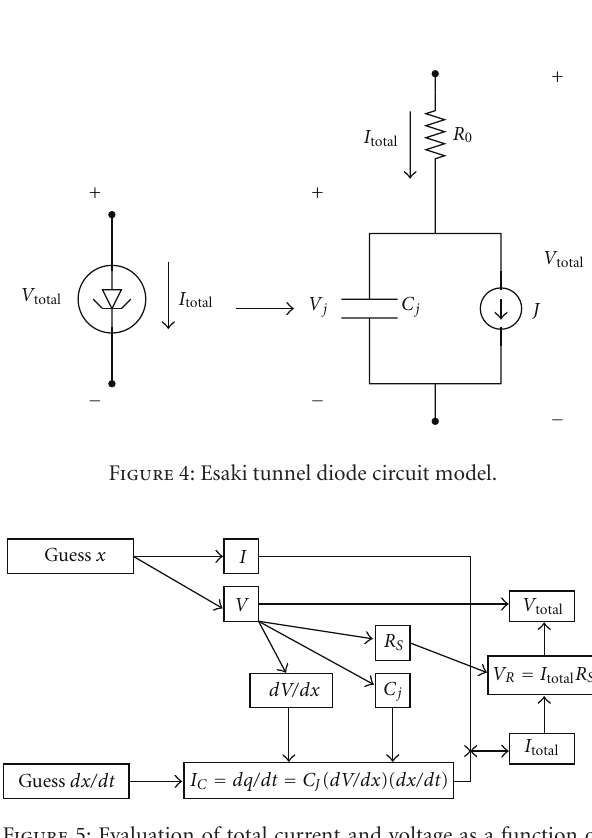
Figure 5: Evaluation of total current and voltage as a function of the state